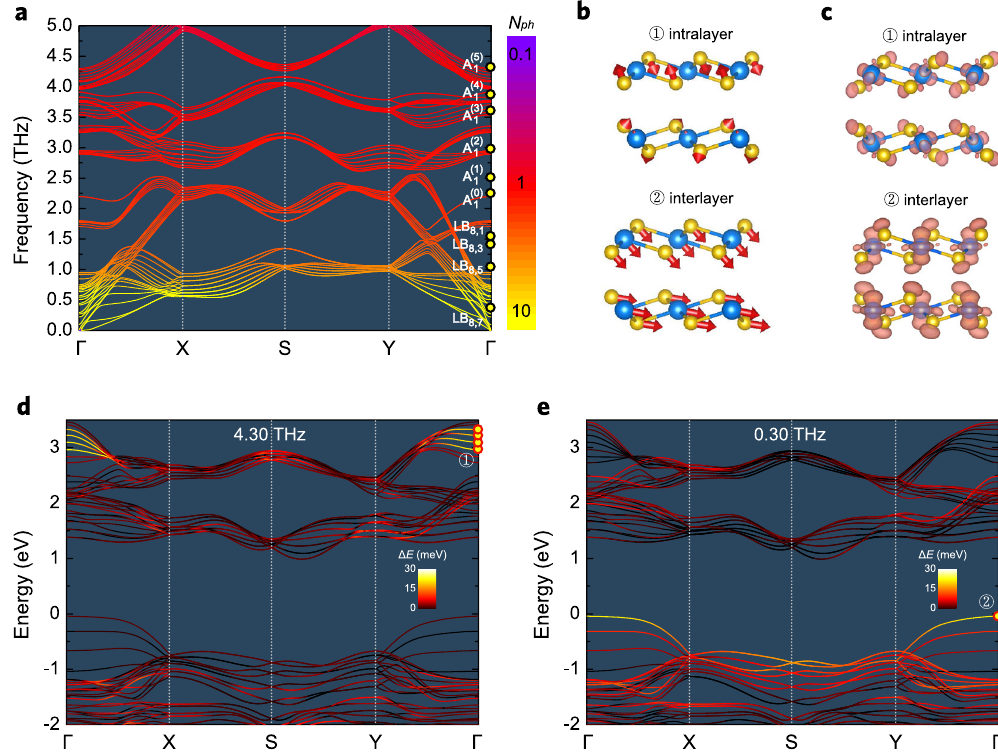
Fig. 6 Lattice dynamics and electron-phonon coupling in PdSe 2 . a Calculated phonon dispersion spectrum of eight-layer PdSe 2 . b Displacement patterns of the intralayer and interlayer modes. c Partial charge density of the electronic states that couple most strongly to the corresponding atomic displacements. Electronic structure modulated by ( d ) intralayer mode at 4.30 THz and ( e ) interlayer mode at 0.30